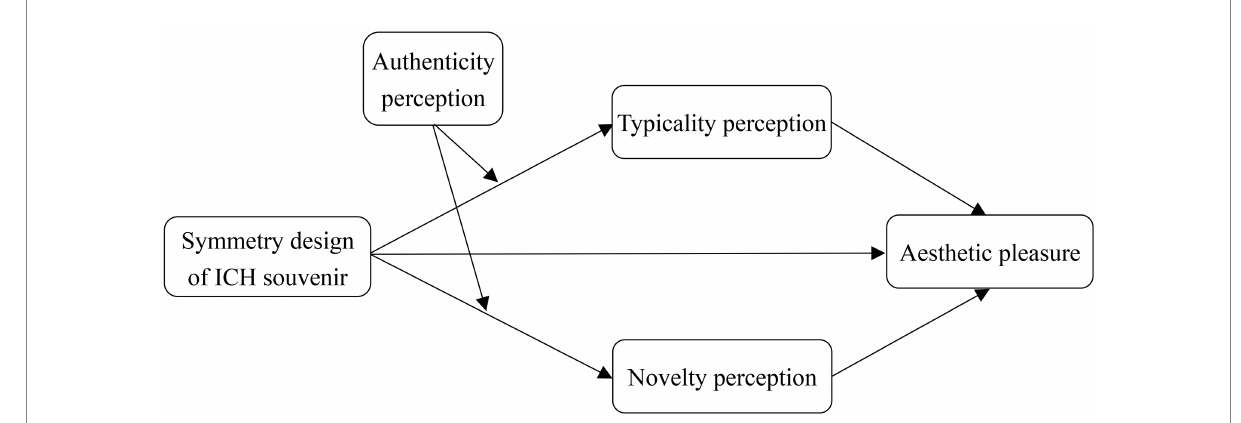
FIGURE 1 The conceptual model.